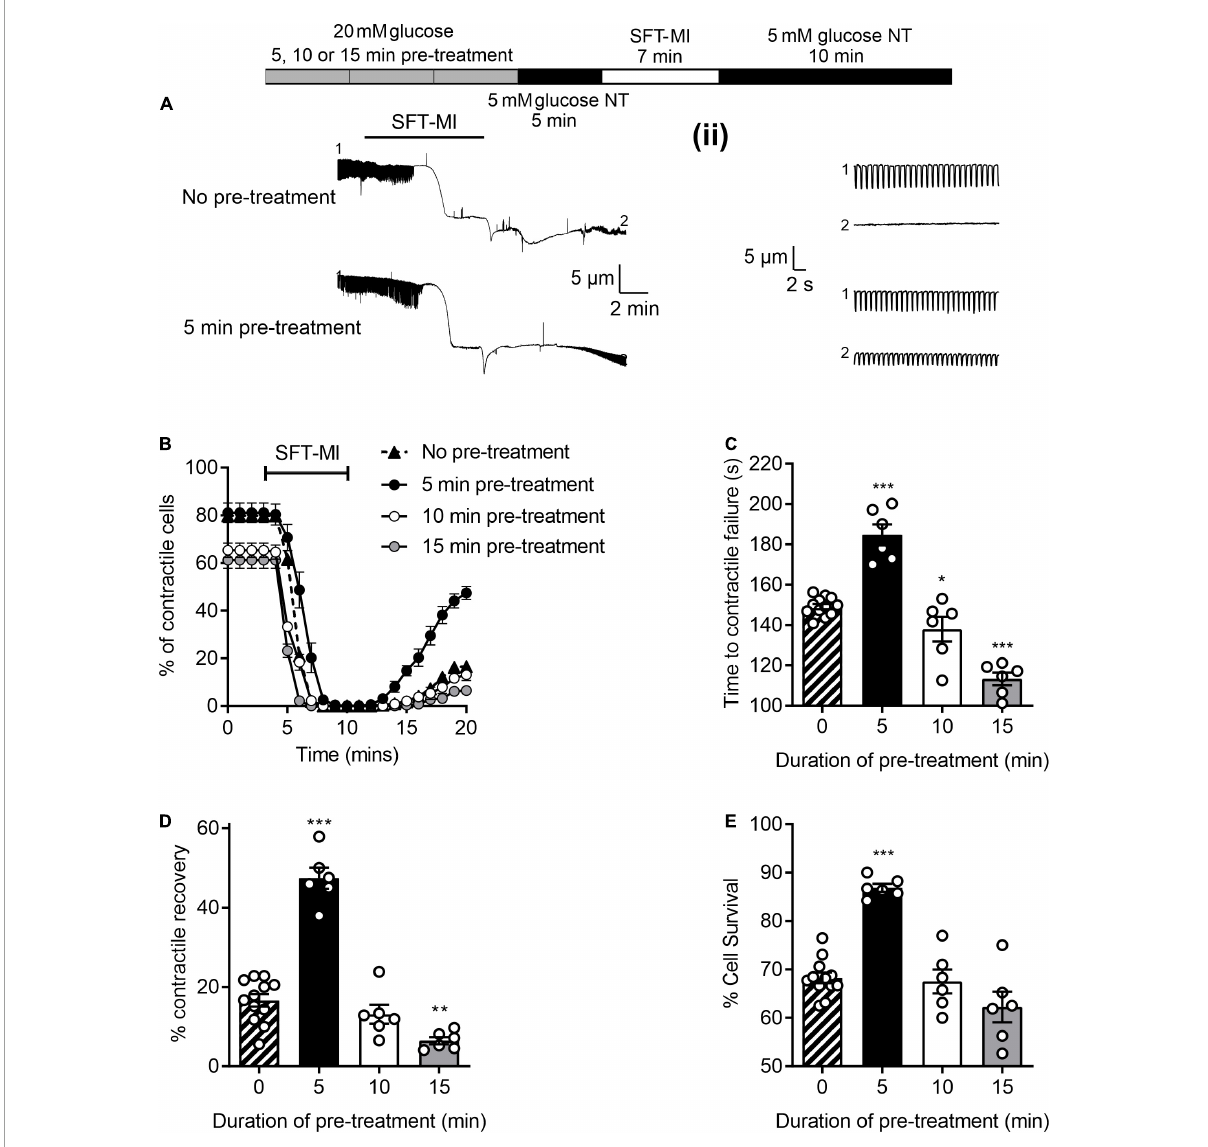
FIGURE3 A short pre-treatment with elevated glucose imparts a cardioprotection, but longer durations reveal glucose-dependent toxicity. (A) Example video edge detection measurements from a cell in control (5 mM glucose) conditions and a cell following 5 min of pre-treatment with glucose prior to the MI/R protocol. (ii) Expanded traces showing 30 s of contractions from the beginning (1) and end (2) of the traces in panel (A) . (B) Time course showing the number of rod-shaped contractile cells from 3 min before the start of the metabolic inhibition in control (no pre-treatment), or following a 5, 10, or 15 min pre-treatment with 20 mM glucose NT. Bar charts showing (C) the mean time to contractile failure in metabolic inhibition, (D) the mean percentage of contractile recovery at the end of the MI/R protocol and (E) the mean percentage cell survival at the end of the MI/R protocol [** P < 0.01, *** P < 0.001, One-Way ANOVA with Holm-Sidak post-test, n = 6 ( > 131) cells for each